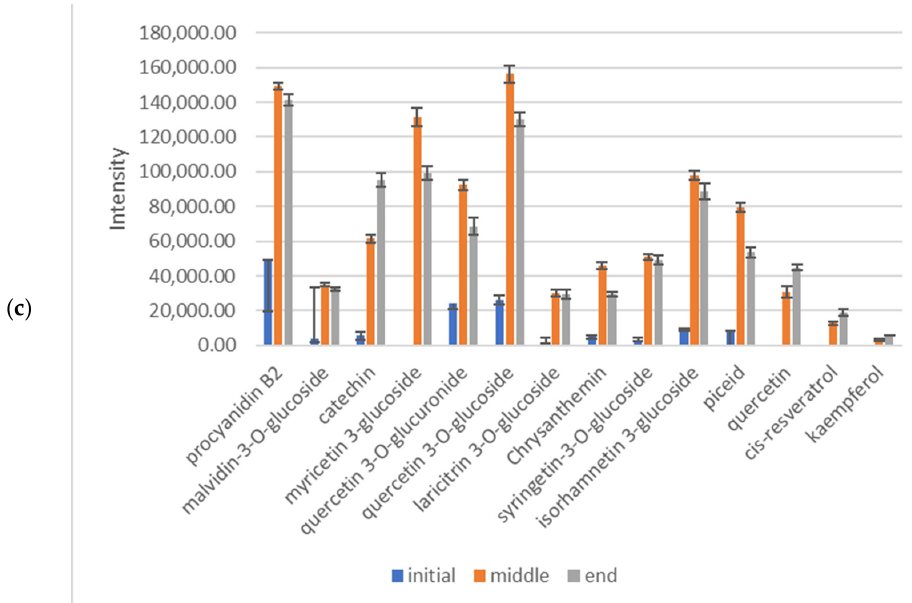
Figure 2. Evolution of the compounds present in the must during the fermentation process for the grapes from site 1: ( a ) glucose and organic acids; ( b ) phenolic acids and their derivatives; ( c ) phenolic compounds. The compound appearing as 4-methoxyphenyl 4-O-(b-D-corresponds to 4-methoxyphenyl 4-O-(b-D-galactopyranosyl)-b-D-glucopyranoside.